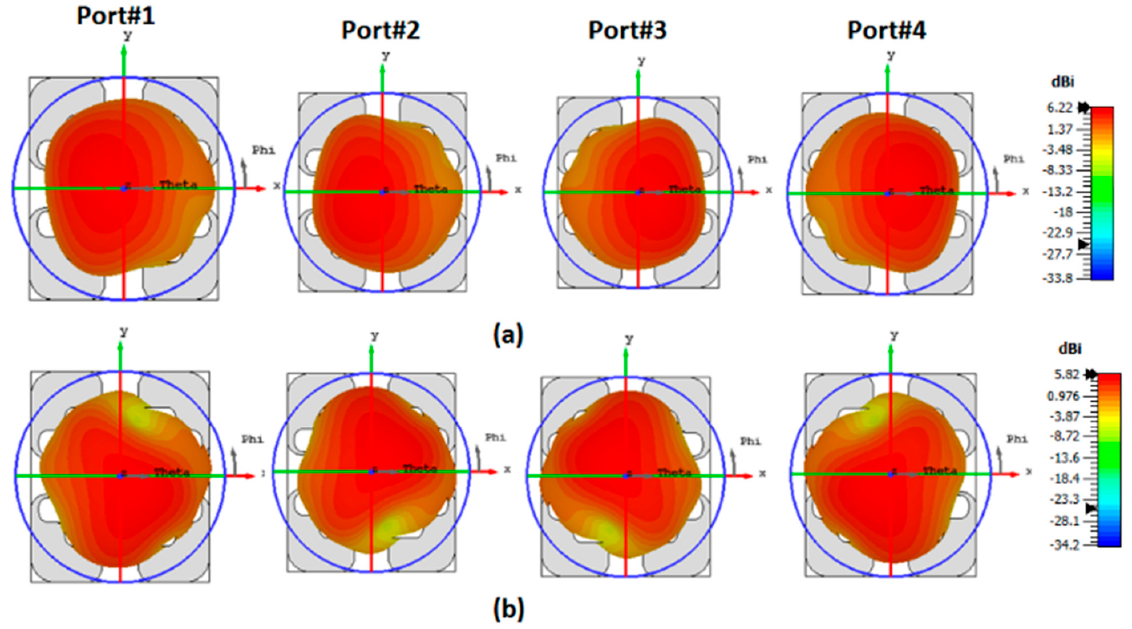
Figure 13. AR response of four-port CP MIMO DRA (simulated and measured).